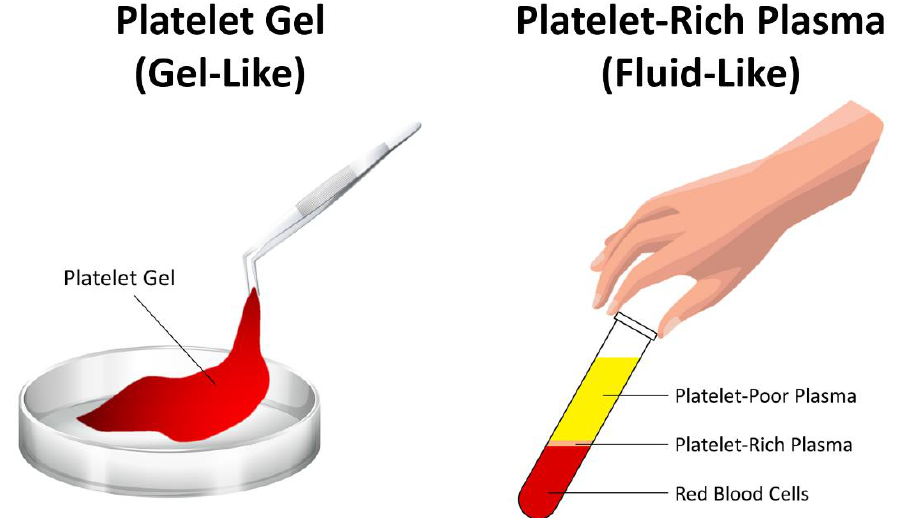
Figure 1. Illustration of gel-like platelet gel and fluid-like platelet-rich plasma.